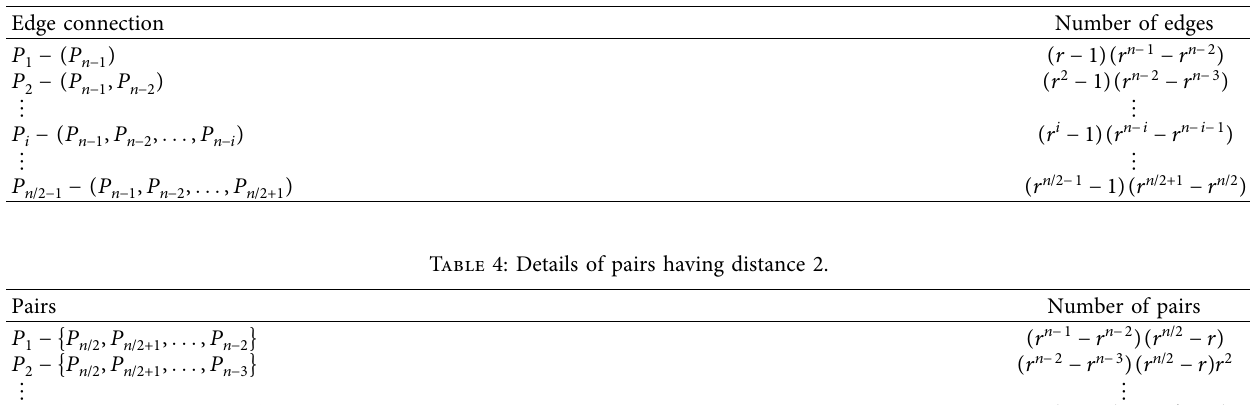
Table 3: Details of edge connections.